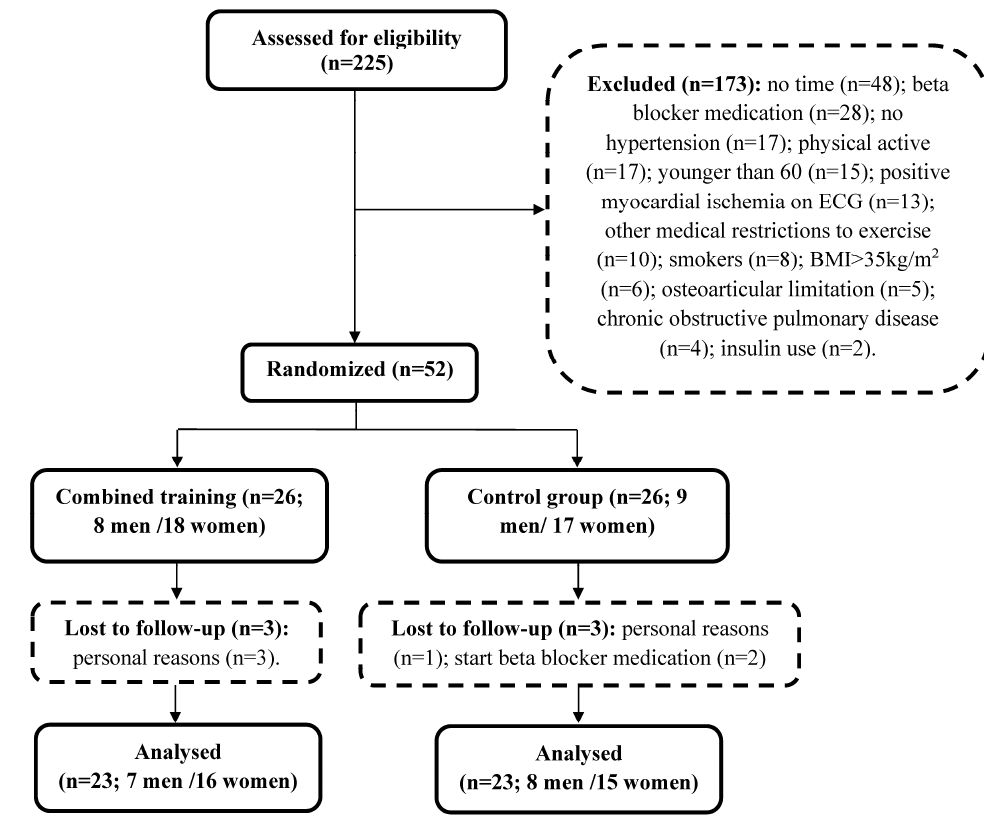
Figure 1. Assessment of eligibility, randomization, and follow-up. Training exhibited reduced body mass and BMI at W16 compared to W0, W4 and Table 2. Cardiometabolic W8, but this lower value (at W16) was not significantly different from Control. Control exhibited an increase in waist circumference at W12 compared to W0, but this was not different from Training (Table 2). No interaction effect was observed for our primary outcome (i.e., BP), and only significant time effects for SBP and ABI, with a reduction in SBP and an increase in ABI from W0 to W12 were observed (Table 2). There was a sig- nificantly lower number of individuals with Metabolic Syndrome (MetS) in Training compared to Control only at W16, according to Chi squared test (Table 2).